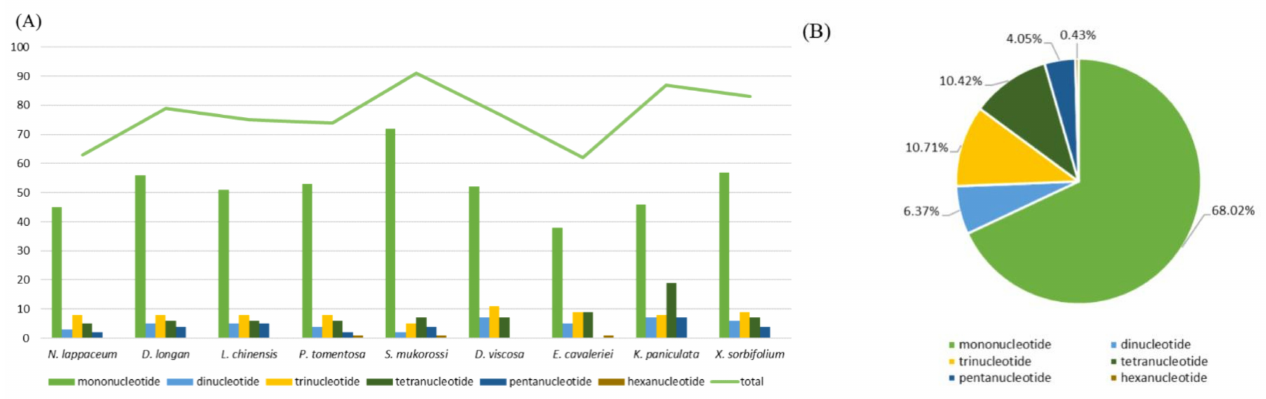
Figure 2. Analysis of simple sequence repeats (SSRs) in nine Sapindaceae (including N. lappaceum ) chloroplast genomes. ( A ) Number of different SSRs types detected in nine Sapindaceae (including N. lappaceum ) chloroplast genomes. ( B ) Presence of different SSRs types in all SSRs of nine Sapindaceae (including N. lappaceum ) chloroplast